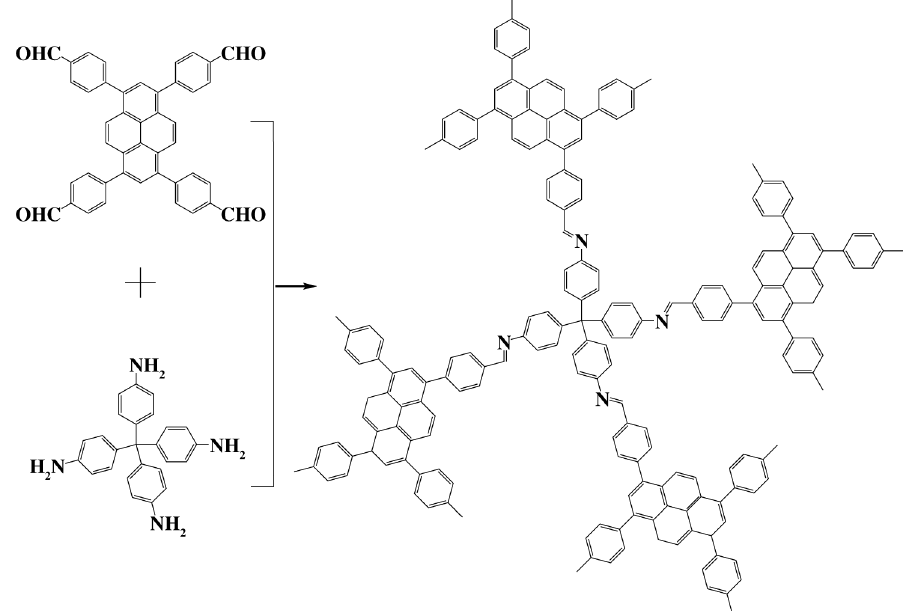
Figure 15: Synthesis and structure of 3D-Py-COF.